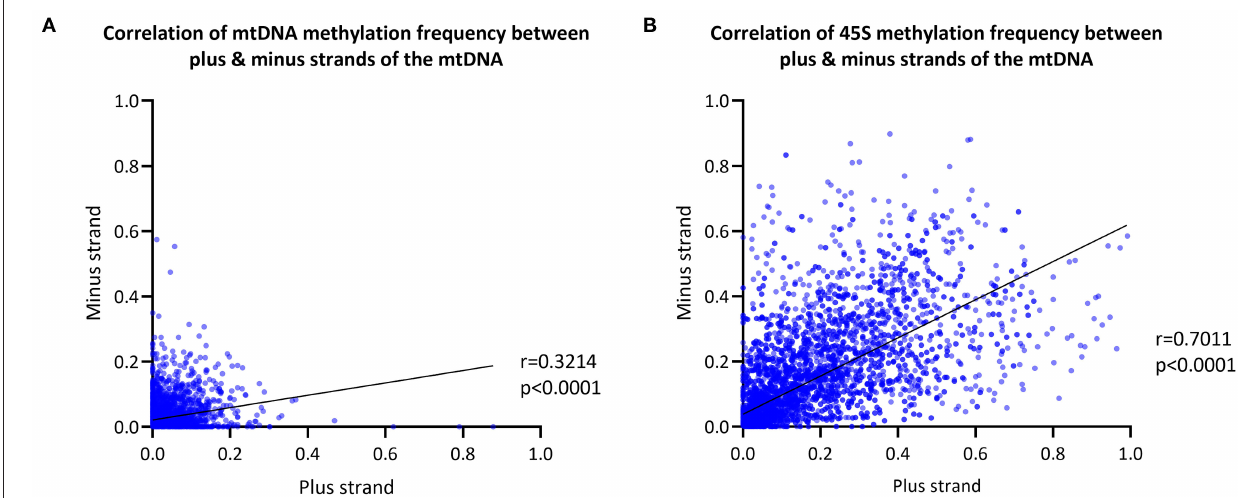
FIGURE 3 | Mitochondrial and 45S rRNA CpG methylation comparison by strand. (A) Correlation between the methylation frequency of the mitochondrial plus- and minus-strand (plus-strand = light-strand, minus-strand = heavy-strand). Data of the six blood-derived samples combined. (B) Correlation between the methylation frequency detected from the 45S rRNA gene plus- and minus-strand. Data of the six blood-derived samples combined. r, Spearman’s rank correlation coefficient; p, Spearman’s exploratory p